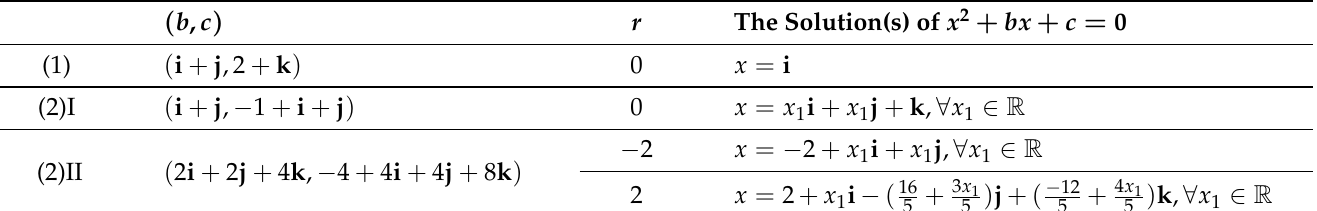
Table 4. Some examples in Theorem